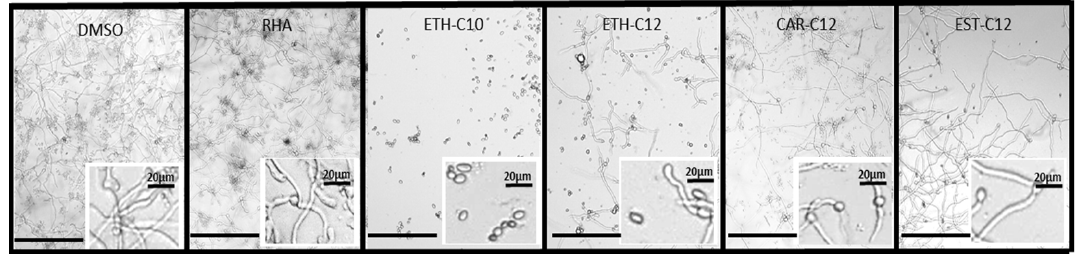
Figure 3. Effect of smRLs at 100 µM on Botrytis cinerea conidial germination 24 hai observed by inverted microscopy. Treatment with DMSO (0.1%) and natural rhamnolipids mix (RHA) served as negative and positive control, respectively. All (sm)RLs were tested at 300 µM. Scale bars correspond to 275 µm.